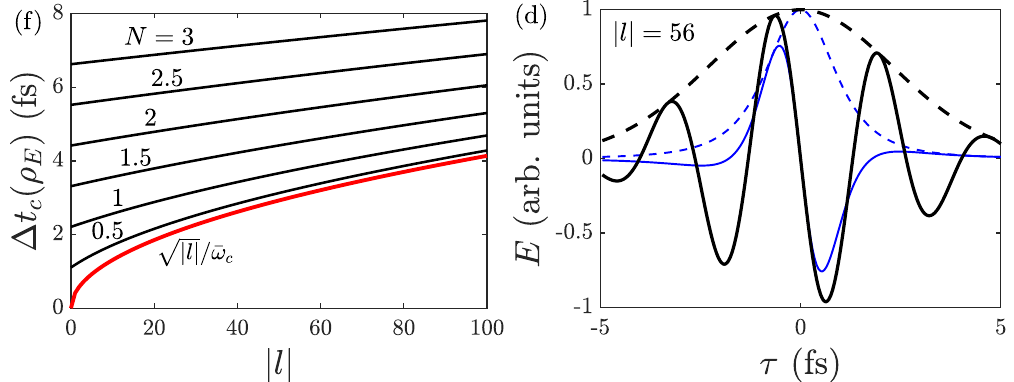
Figure 4. ( a ) Power-exponential spectrum ˆ a ω in Equation (31) with ¯ ω c = 2.417 rad/fs and β = 3.56. ( b – d ) Real part and amplitude of the half-cycle ( N = 0.5) pulse a ( τ ) in time domain (blue curves), and real part and amplitude of the pulse in the most intense ring of ultrafast vortices with the indicated values of | l | , as given by Equation (34). All pulse shapes are normalized to their peak values for a better comparison. ( e ) With z R = 10 mm, peak intensity of the pulse as a function of radius at the waist z = 0 (cid:112) | l | /2 s ¯ ω for the three values of | l | with maxima at r E ( 0 ) = . ( f ) Central duration of vortices in their c most intense ring as a function of the magnitude of the topological charge | l | , for power-exponential laser spectra with ¯ ω c = 2.417 rad/fs, and with β = 3.56 ( N = 0.5), β = 14.24 ( N = 1), β = 32.04 ( N = 1.5), β = 56.95 ( N = 2), β = 89.0 ( N = 2.5), and β = 128.15 ( N = 3). The red curve is the